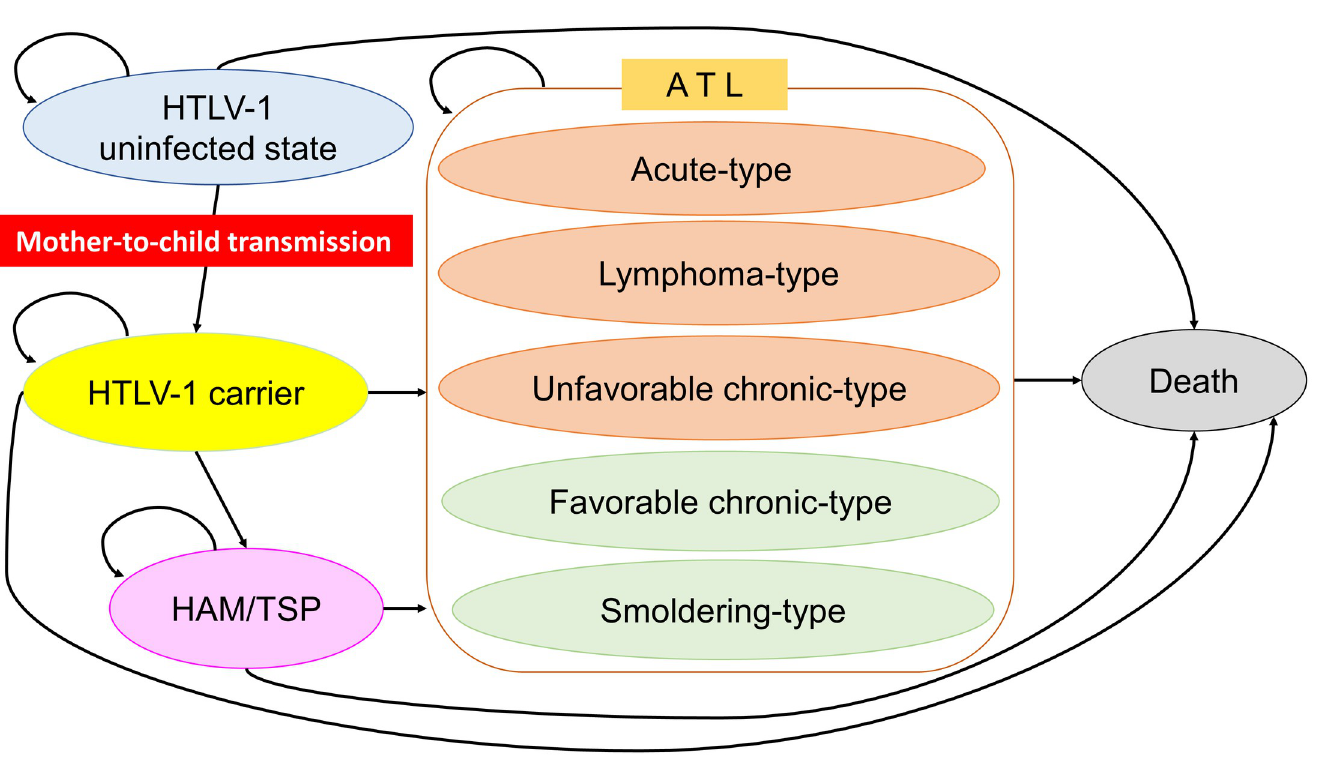
Fig 1. Simplified schematic depiction of a state transition diagram. The health states in the model are shown to be oval. In a yearly model cycle, transition paths occur between the health states and other health states, as represented by the arrows. HTLV-1, human T-cell leukemia virus type 1; ATL, adult T-cell leukemia-lymphoma; HAM/TSP, HTLV-1-associated myelopathy-tropical spastic paraparesis.